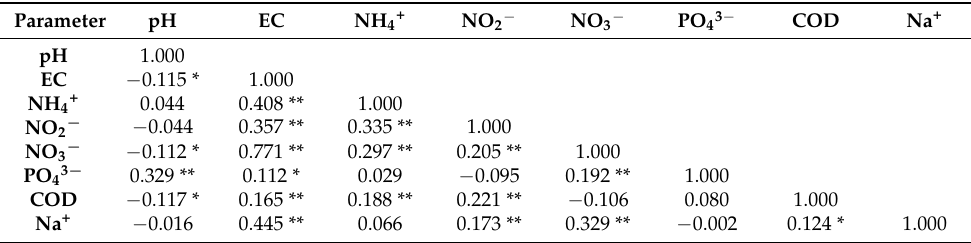
Table 3. Correlation matrix of the investigated parameters.